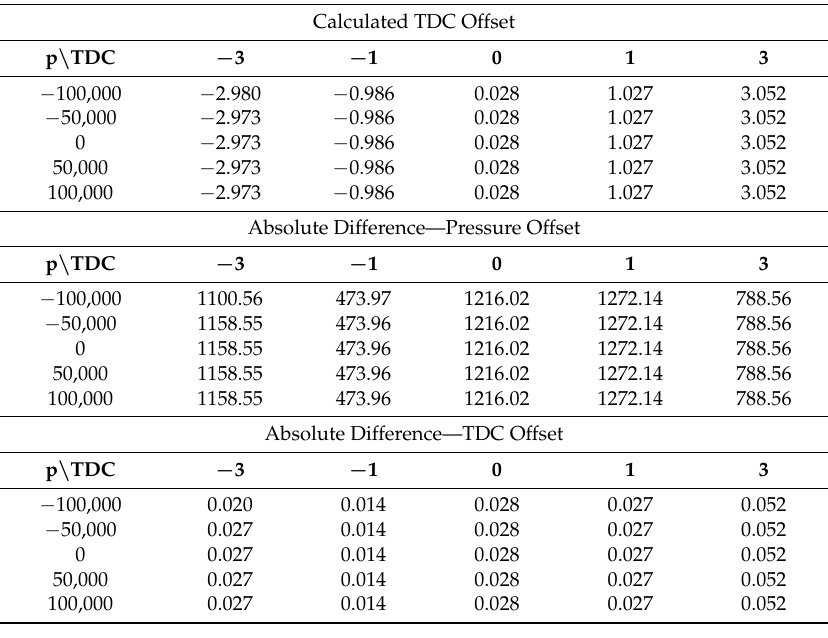
Table 6. Number of iterations for the PSA engine and operating point 2000 1/min and 100 Nm using the off-line method.